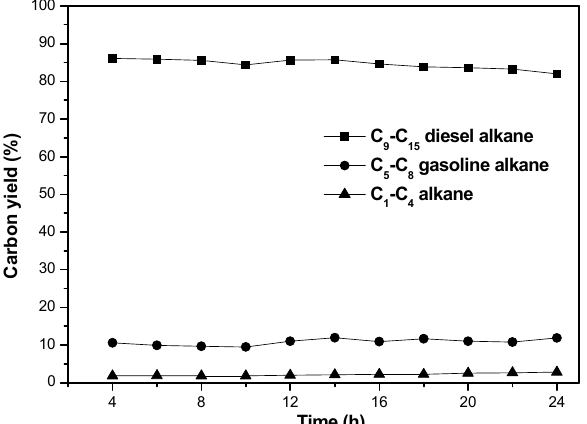
Figure 8. Carbon yields of different hydrocarbons over the Pd / H-ZSM-5 catalyst. Experimental conditions: 1.80 g catalyst, 6.0 MPa H 2 , 573 K, 2,5-bis(furan-2-ylmethyl)-cyclopentanone flow rate of 0.04 mL min − 1 , and hydrogen flow rate of 120 mL min − 1 .